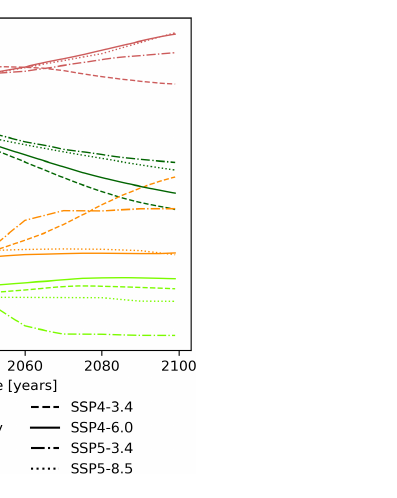
Figure A3. Global areas of the four BLUE land-cover types based on the LUH2 dataset in four future scenarios described in the text.